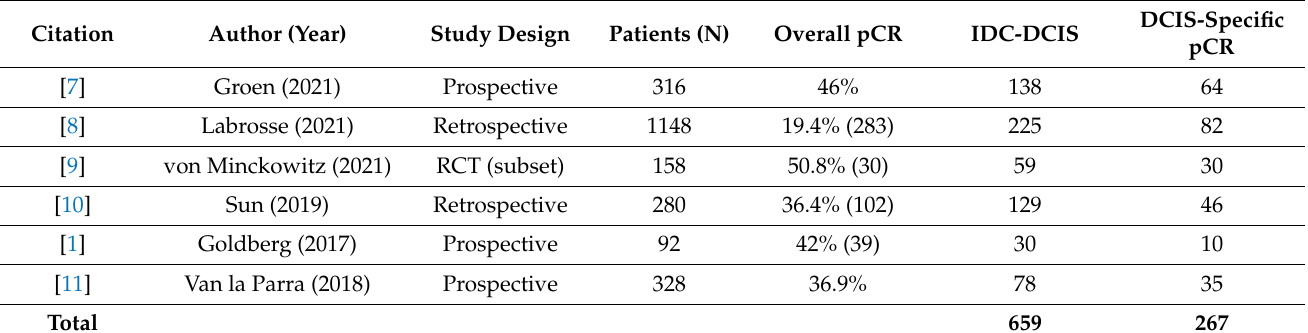
Table 1. Six studies regarding residual DCIS after NST, satisfying the inclusion and exclusion criteria after systematic review of the literature. In pooled analysis, 40.5% (267/659) patients achieved complete eradication of DCIS after NST. DCIS: ductal cancer in situ; IDC-DCIS: co-existent DCIS